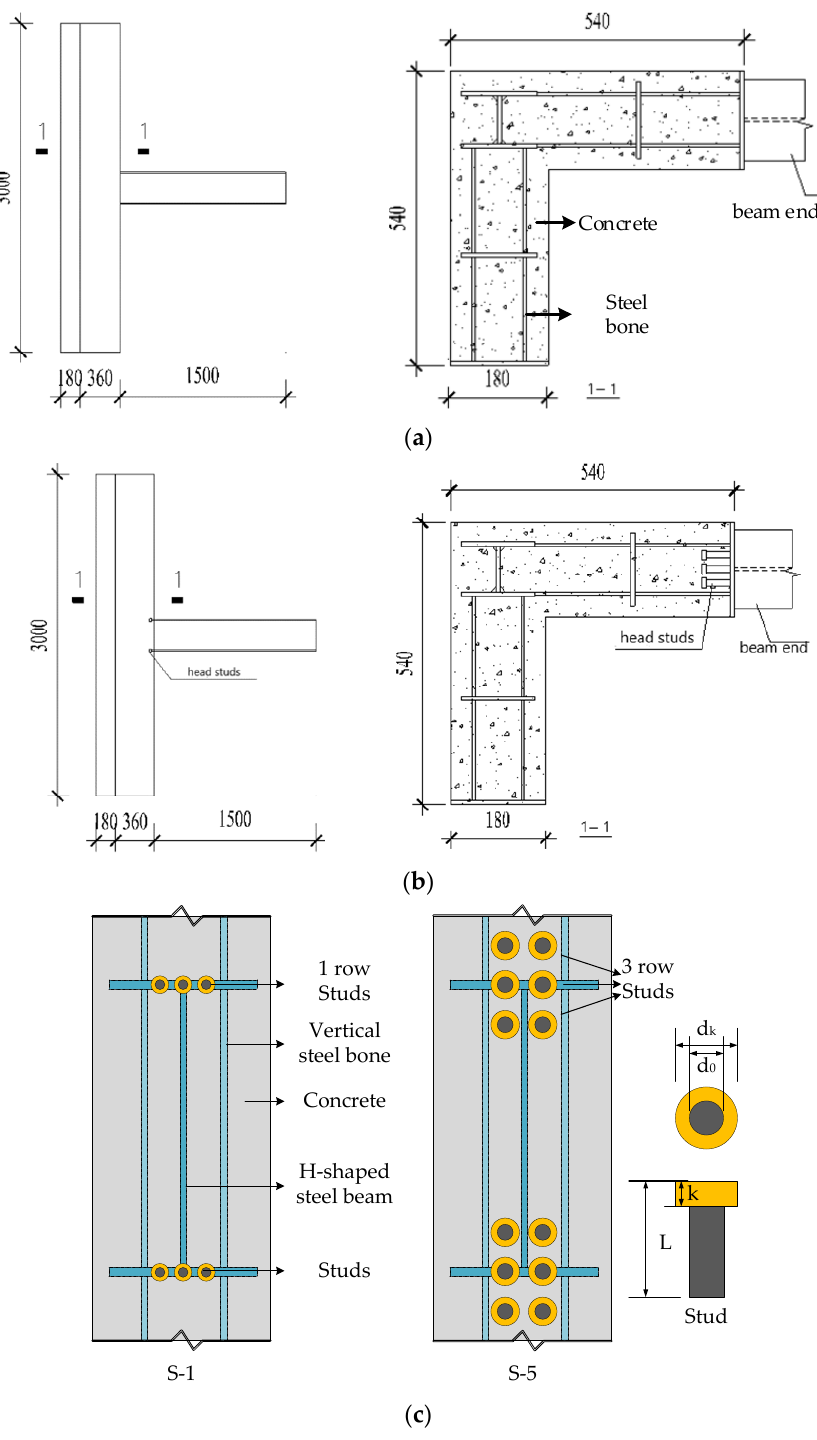
Figure 1. Schematic diagram of beam ‐ column joints. ( a ) JD joint for comparison (unit: mm); ( b ) S series joint (unit: mm); ( c ) Schematic diagram of stud position. Where d 0 is the diameter of the stud, d k is the diameter of the head stud; k is the height of the head stud; L is the total length of the